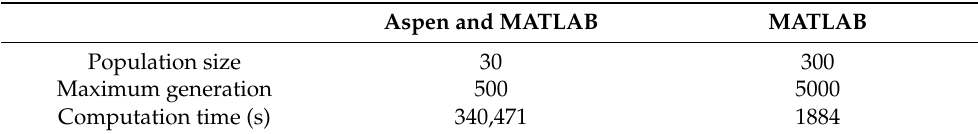
Table 8. Parameter comparison of the optimization methods.